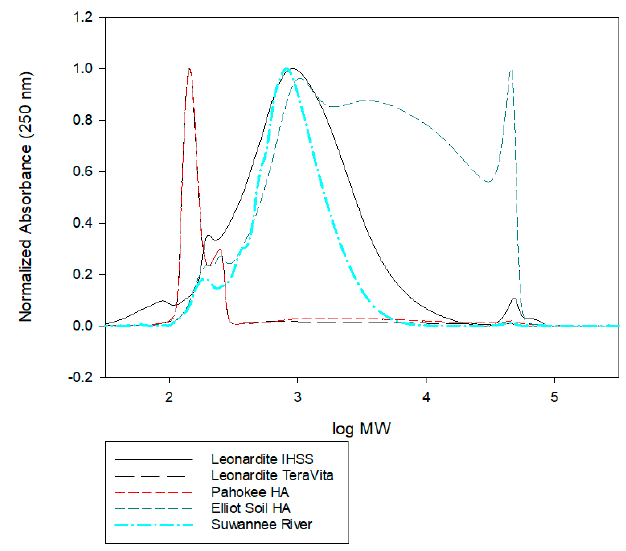
Figure 13. SEC results for humic materials utilized in this investigations. All of the humic materials had a broad distribution of molecular weights with a significant contribution of materials that are less than 500 mW.